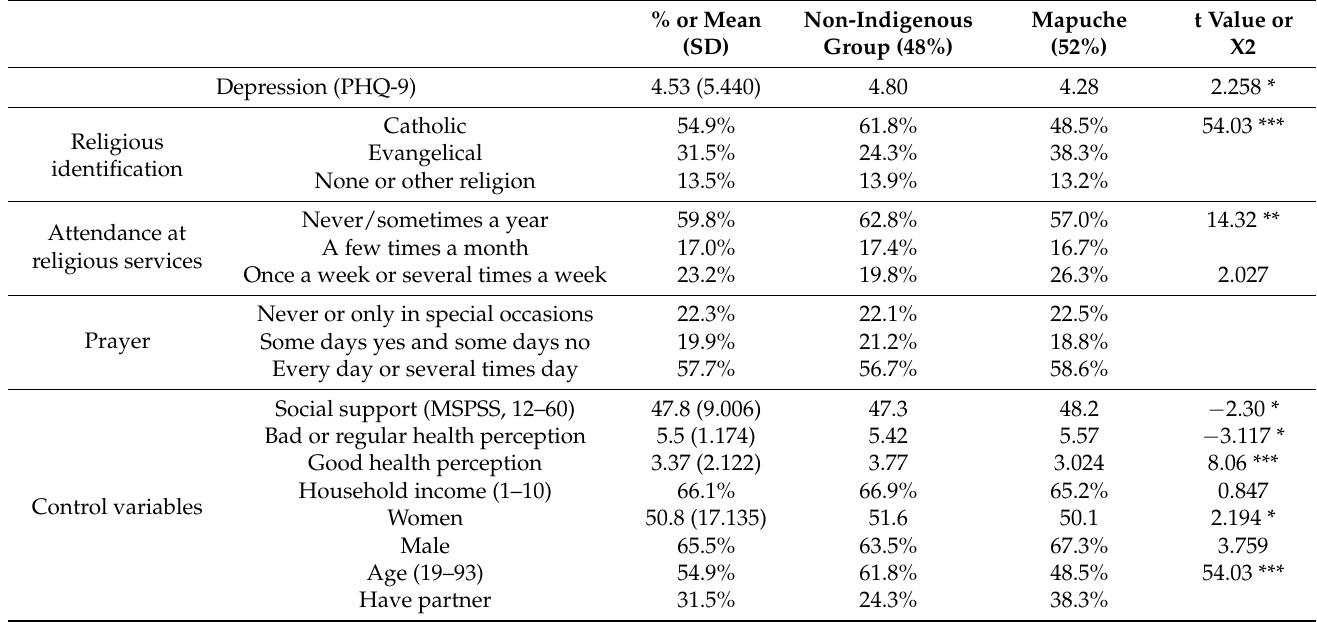
Table 1. Descriptive Analysis.